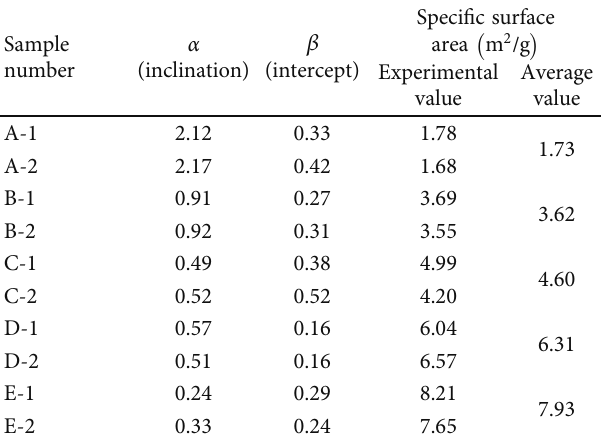
Table 6: BET-speci fi c surface area test results of gypsum rock. Sample